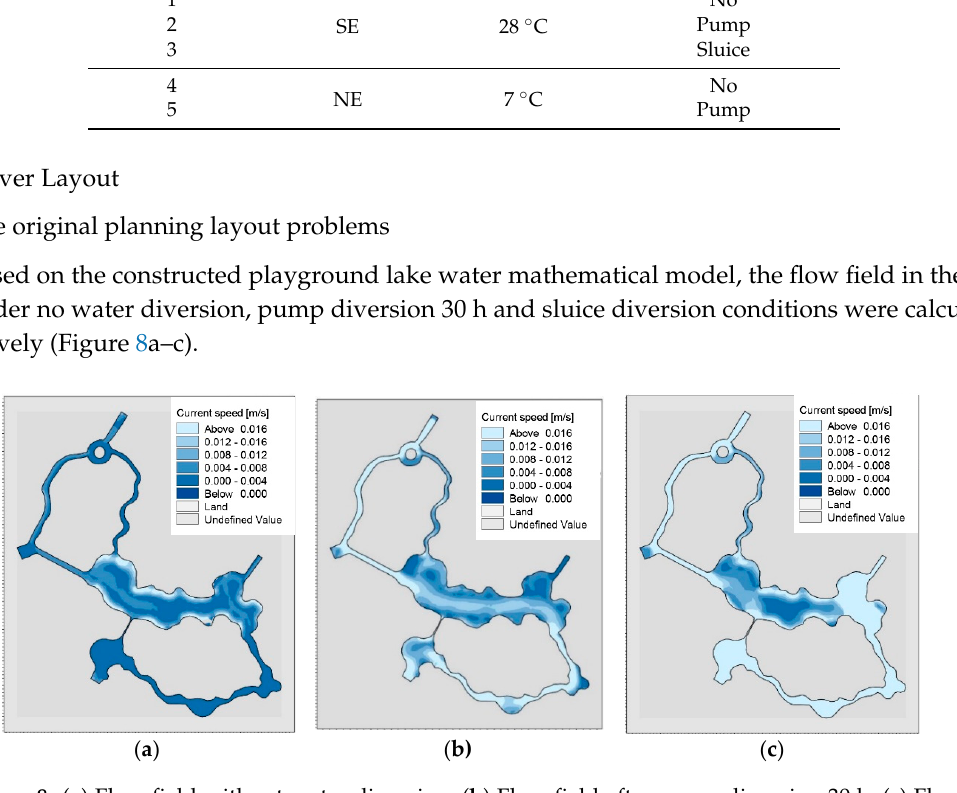
Figure 8. ( a ) Flow field without water diversion; ( b ) Flow field after pump diversion 30 h; ( c ) Flow field after sluice diversion.